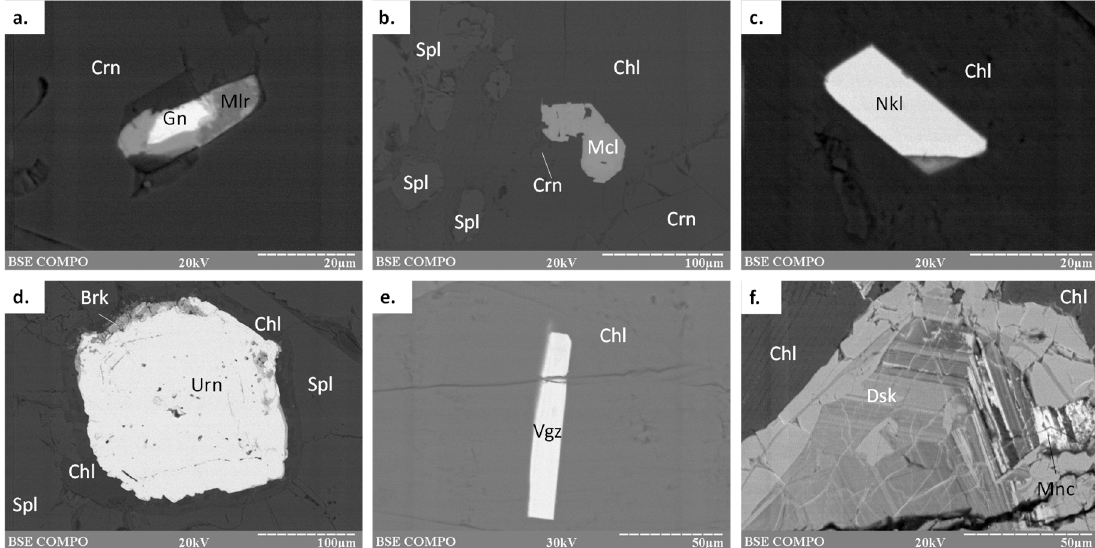
Figure 5. BSE images of corundum ‐ spinel ‐ chlorite samples from the central zone: ( a ) Millerite and galena inclusions within corundum; ( b ) Corundum ‐ spinel ‐ clinochlore intergrowth with inclusion of microlite; ( c ) Nickeline inclusion within clinochlore; ( d ) Uraninite ‐ brokkite ‐ clinochlore concentric aggregate within spinel; ( e ) Vigezzite inclusion within clinochlore; and, ( f ) Dissakisite ‐ (Ce) ‐ monazite ‐ (Ce) aggregate within clinochlore. Mineral abbreviations are after [12]. BSE images by V.A. Kotlyarov.